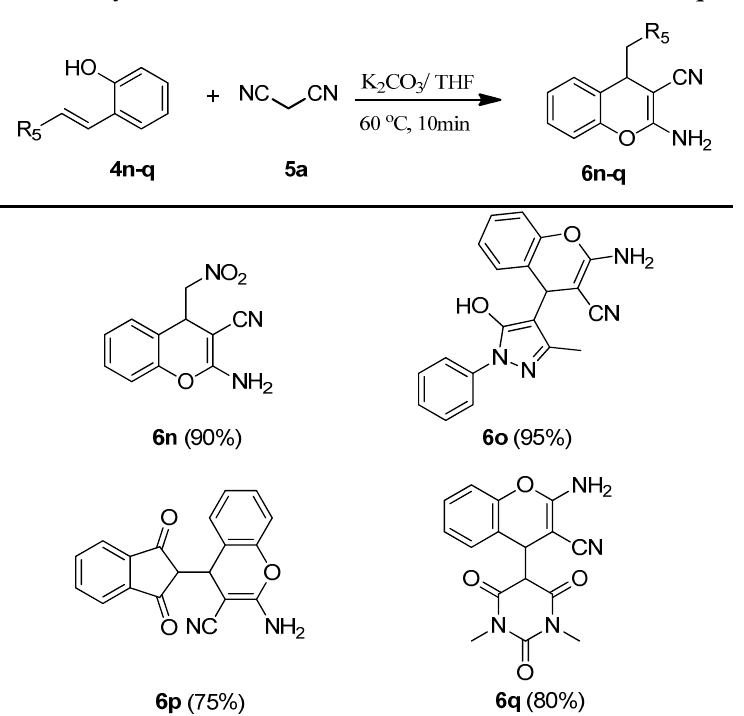
Table 3. Synthesis of more substituted 4 H -chromenes 6n – q a,b